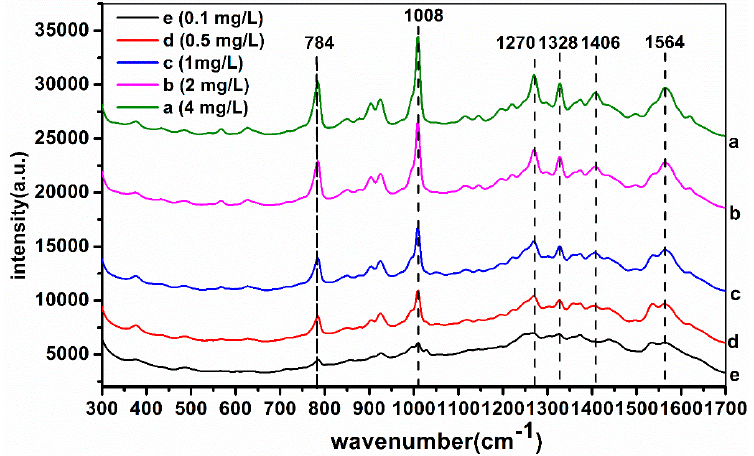
Figure 4. The SERS of TBZ in red soil extracts: ( a ) 4 mg/L; ( b ) 2 mg/L; ( c ) 1 mg/L; ( d ) 0.5 mg/L; ( e ) 0.1 mg/L.